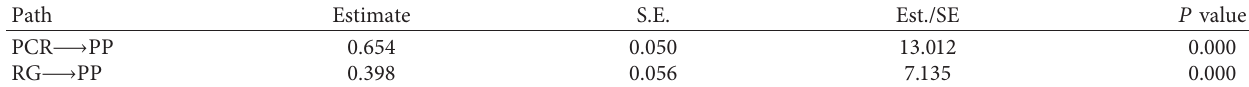
Table 3: Standardized path coefficient.